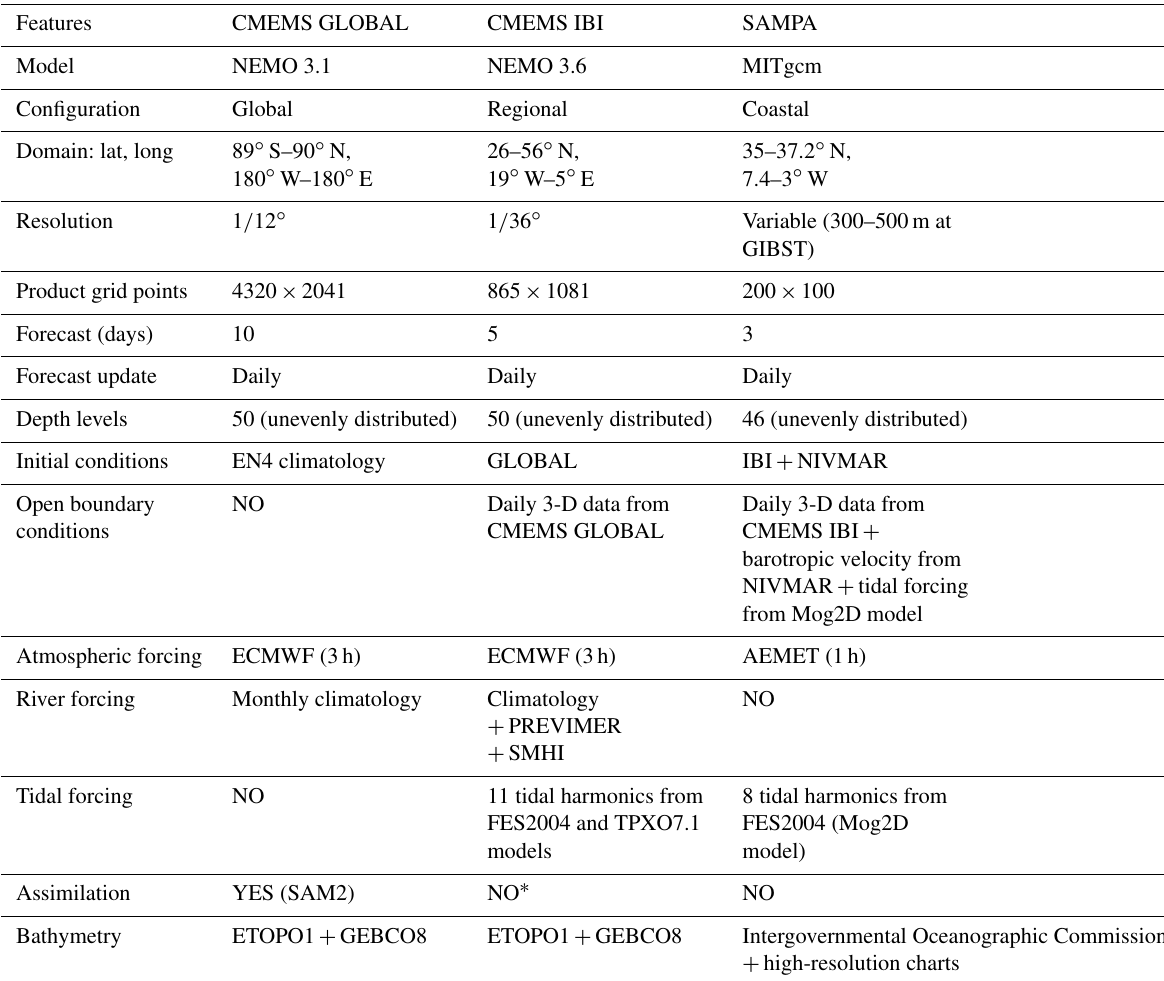
Table 1. Basic features of the ocean forecast systems employed in the present study. ∗ The operational version of IBI used with spectral nudging. Assimilation scheme SAM2 was later introduced in version 4 (April